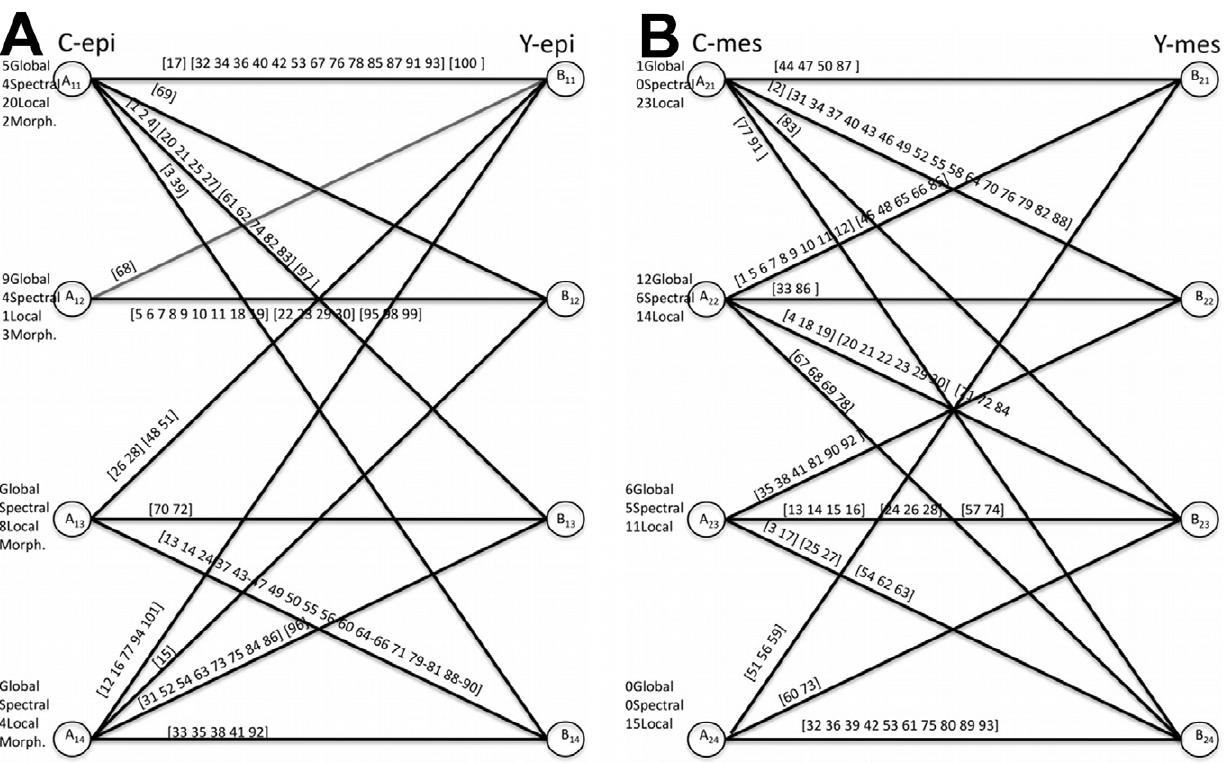
Figure 5. Bipartite graph analysis. The changes in the correlation clusters of the four tissue samples are studied through bi-partite graph analysis for the untreated vs. treated epithelial tissue comparison in (a) and for the untreated vs. treated mesenchymal tissue comparison in (b).